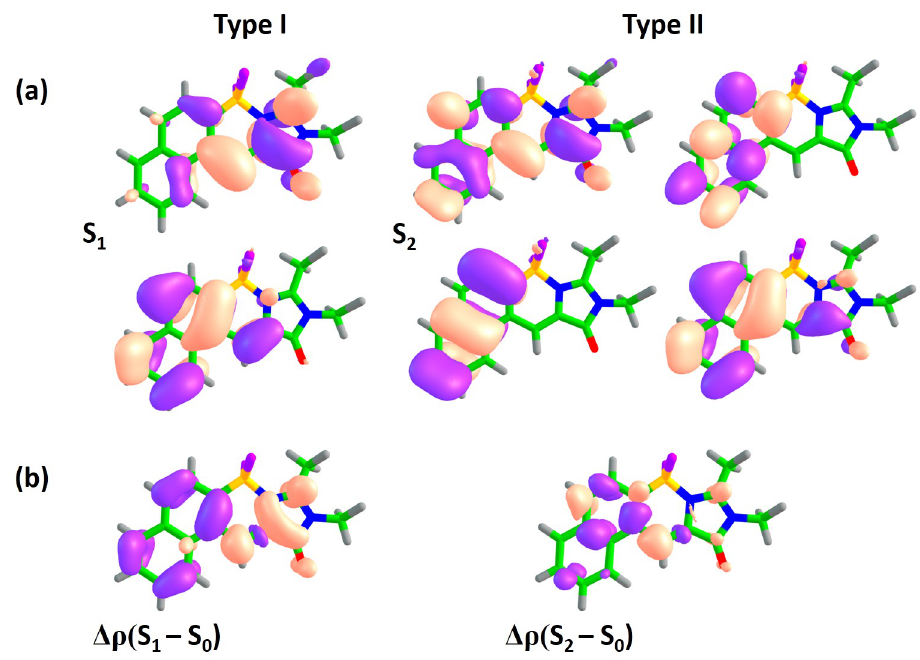
Figure 5. XMCQDPT2 natural orbitals actively involved in the S 0 –S 1 and S 0 –S 2 transitions ( a ) and the corresponding differential electron densities ∆ ρ ( b ) for compound 1B . For each state, the excitation is directed from the lower orbital to the higher orbital. The color code stands for negative and positive ∆ ρ values depicted in blue and red,